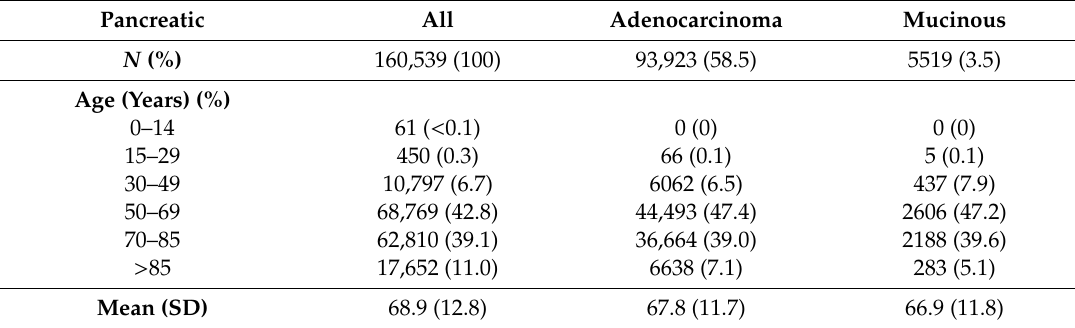
Table 9. Baseline demographics and clinical characteristics by histology for pancreatic cancers. Pancreatic